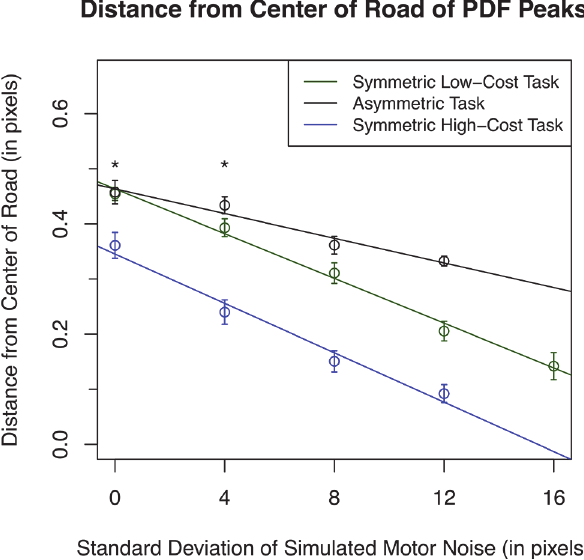
Fig 6. Regression on the distance from the center of the road subjects maintained vs. level of motor noise. Points indicate the mean distance from the center of the road of all subjects derived from the peaks of the fitted probability density functions (see methods) for each task type and uncertainty level. As motor noise increased, subjects ’ position shifted proportionally toward the center of the road. Position is normalized to 250 pixels so 0 is the center of the road and 1 is the edge of the road. Errors bars indicate the standard error of subjects. Solid lines represent the linear regressions fit for each task type. Asterisks indicate the pairs of values with insignificant